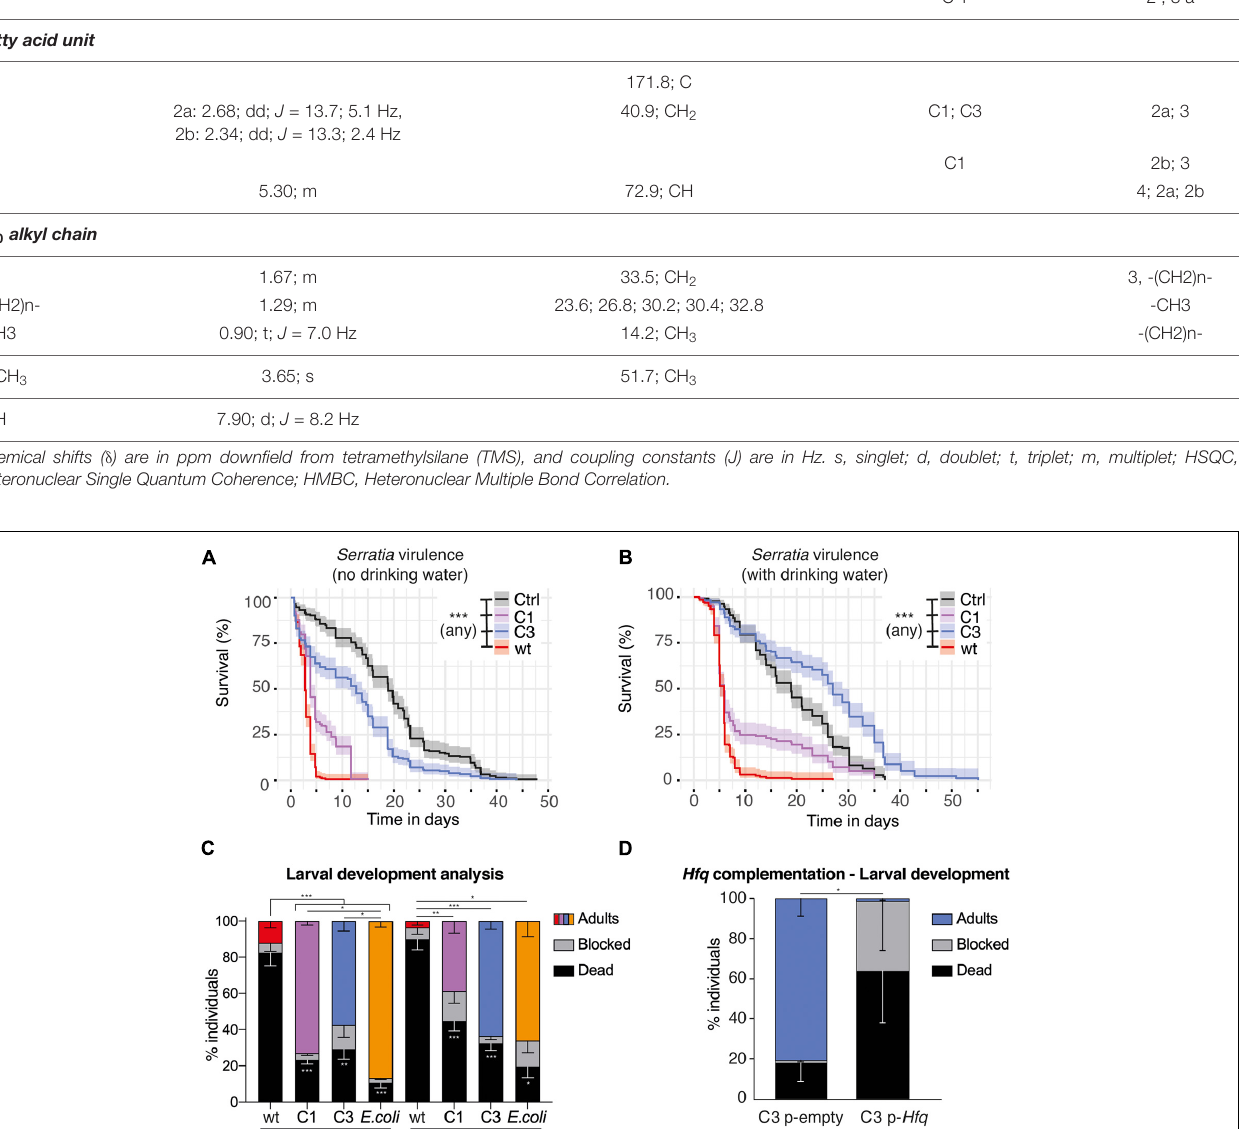
Frontiers in Microbiology |